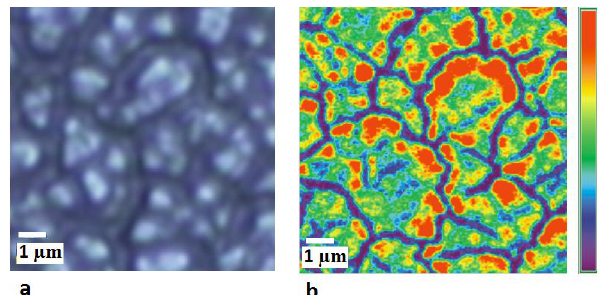
Figure 4: (a) Optical image of 2400 nm CeO2 surface; (b) intensity distribution maps for mainRaman peak of 2400 nm CeO2. Red - 300 CCD counts, violet - 1700 CCD counts.